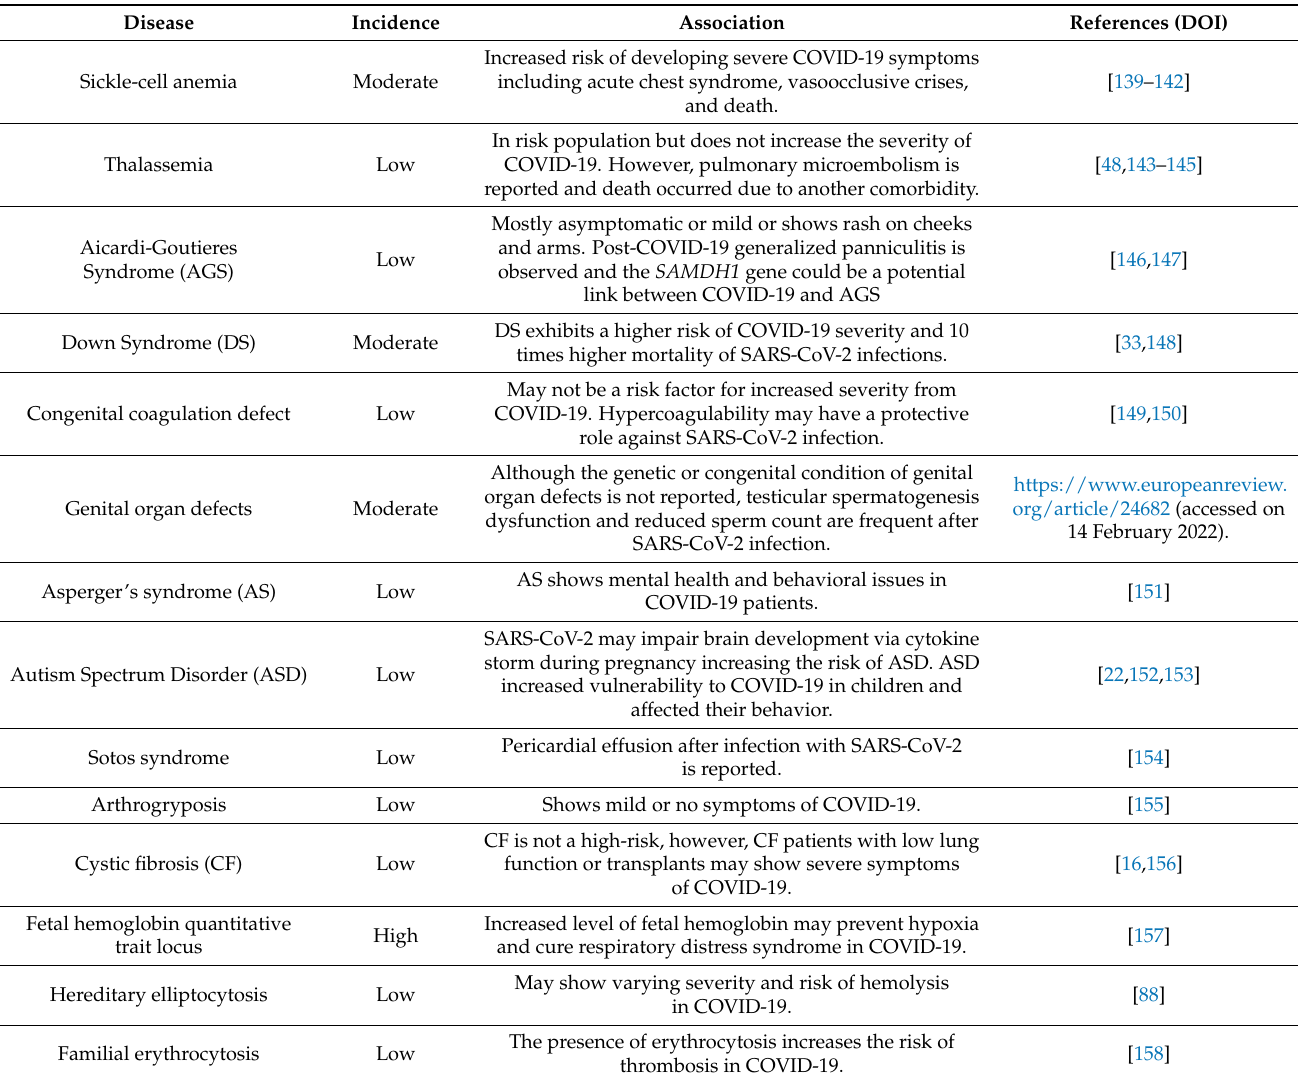
Table 1. A snapshot of reported associations of COVID-19 with congenital anomalies and genetic diseases. Disease